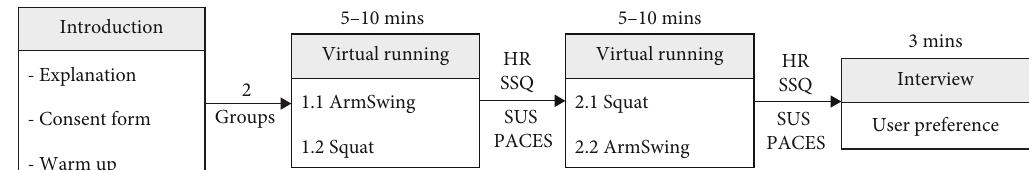
Figure 4: Research protocol with two groups of participants in the